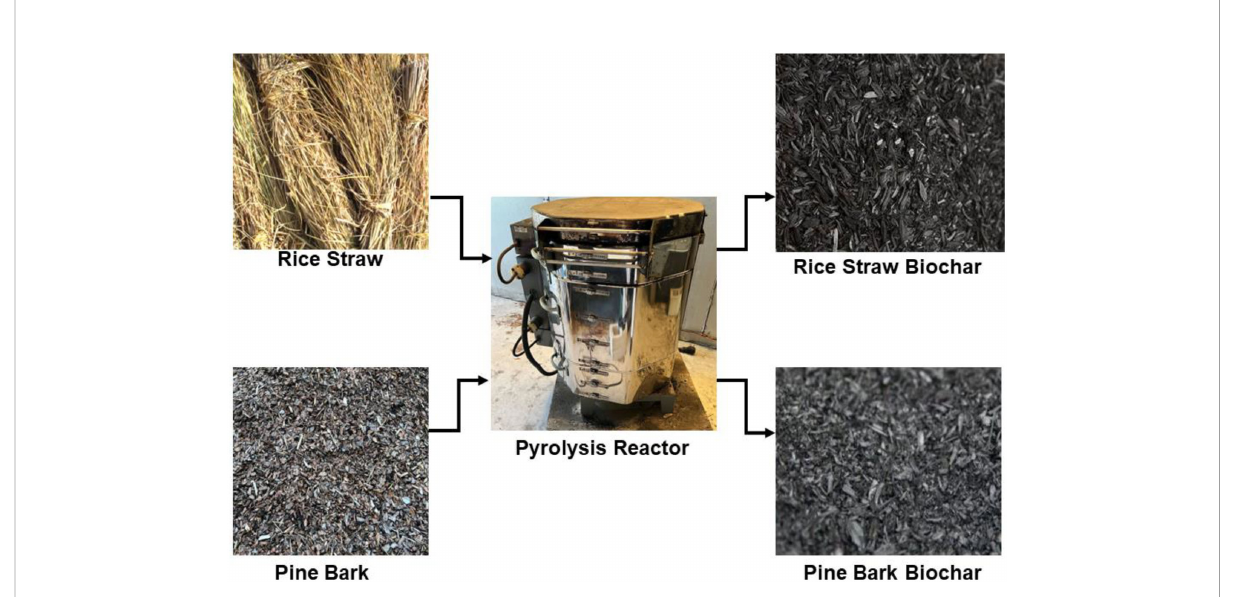
FIGURE 3 Various biochars made from agricultural waste material in a pyrolysis reactor.